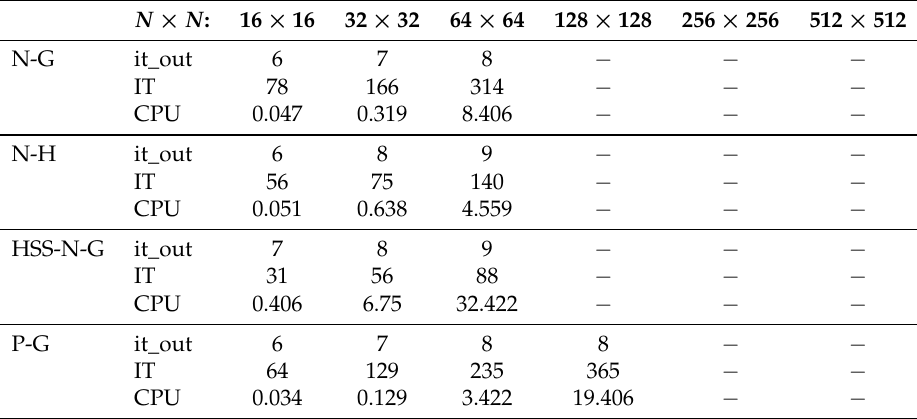
Table 5. Iteration counts and elapsed CPU time for Case 1.2